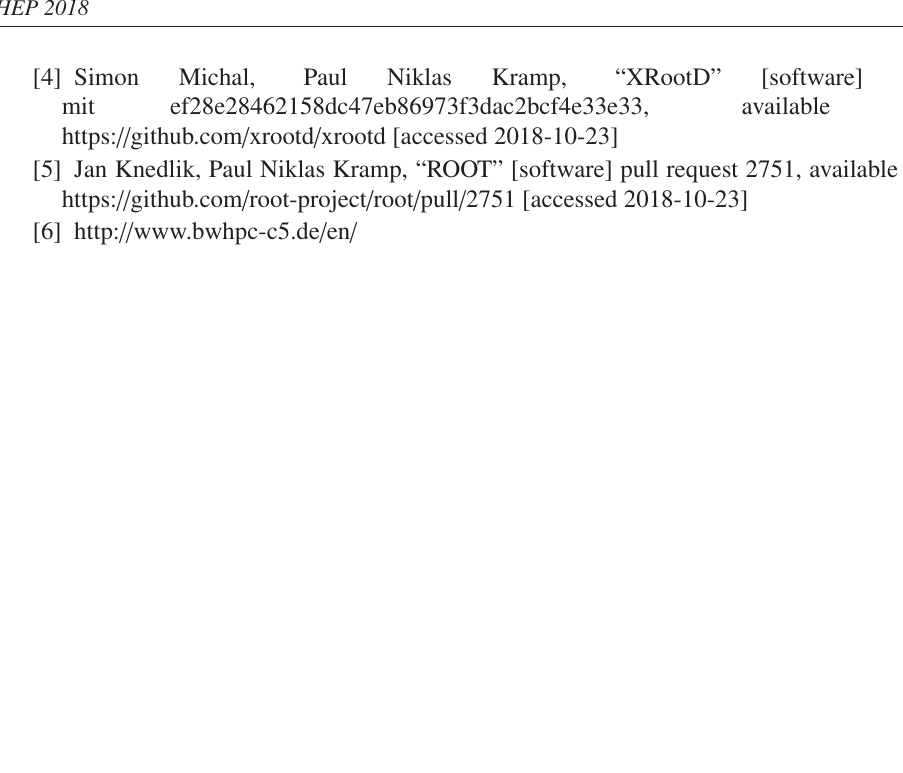
Figure 2. Disk Caching Proxy